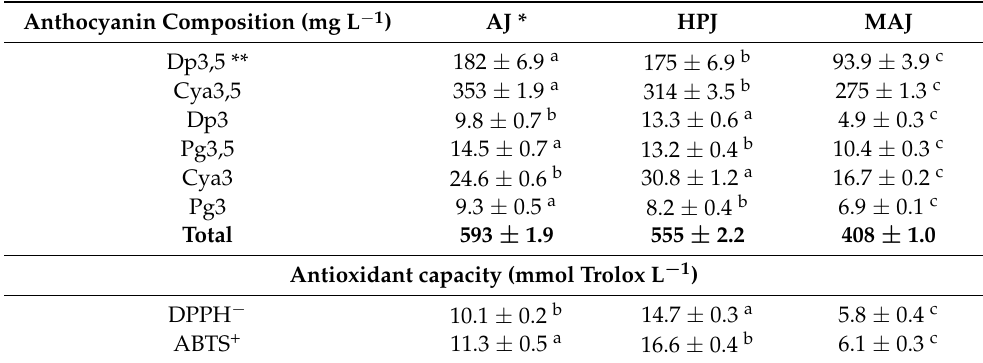
Table 3. Individual anthocyanins and antioxidant capacity of pomegranate juice samples. Anthocyanin Composition (mg L − 1 ) AJ